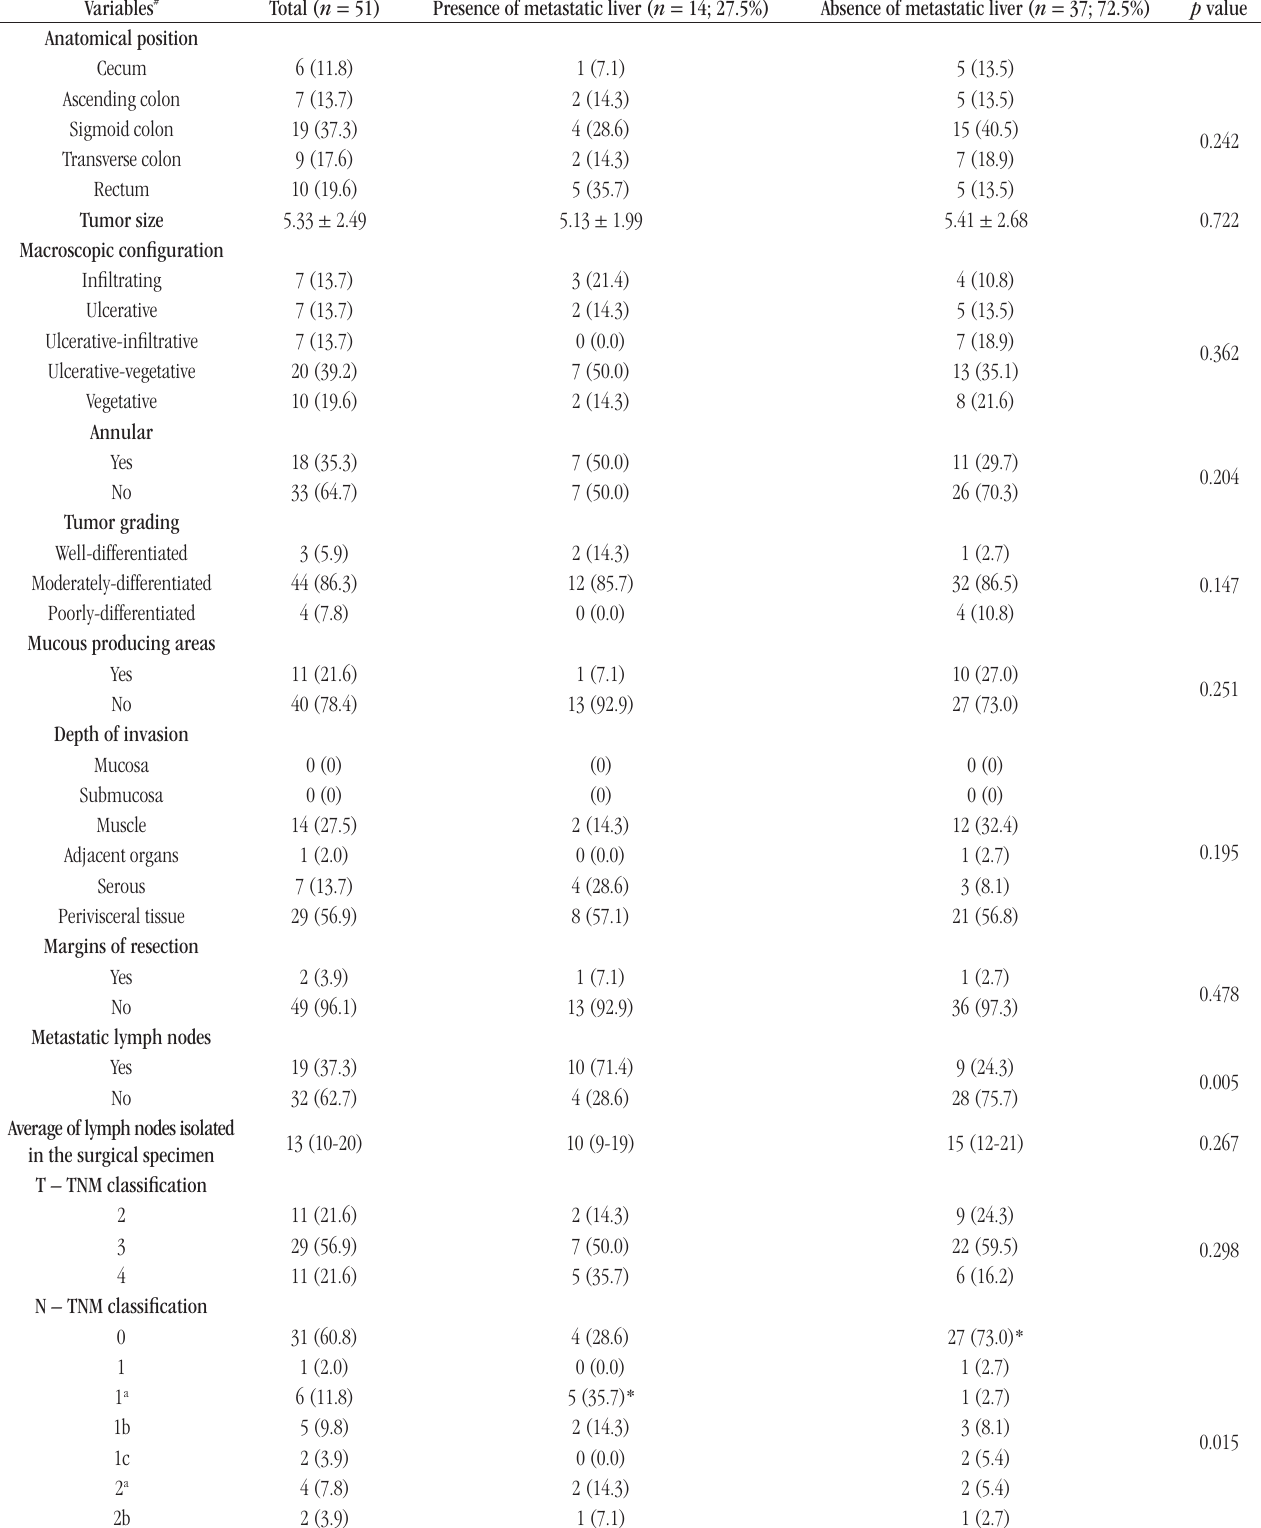
taBLE 2 – LIA: comparison between groups regarding the